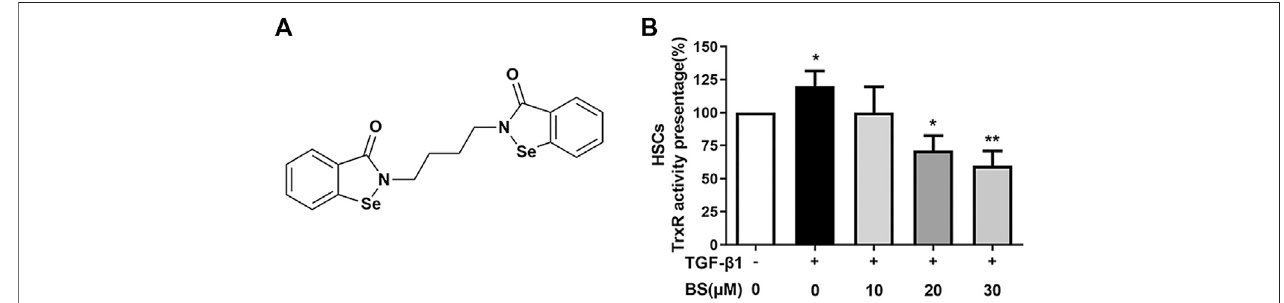
FIGURE 2 | BS decreased TrxR activity in activated HSCs. (A) Chemical structure ofBS. (B) The TrxR activity was assessed in activated HSCs, and the cells were inducedby5 ng/mlTGF- β 1.Datawereshownasmean ± SD,n ≥ 3andanalyzedwiththeone-wayANOVA.* p < 0.05,TGF- β 1positive,and0 μ MBSgroup versus TGF-